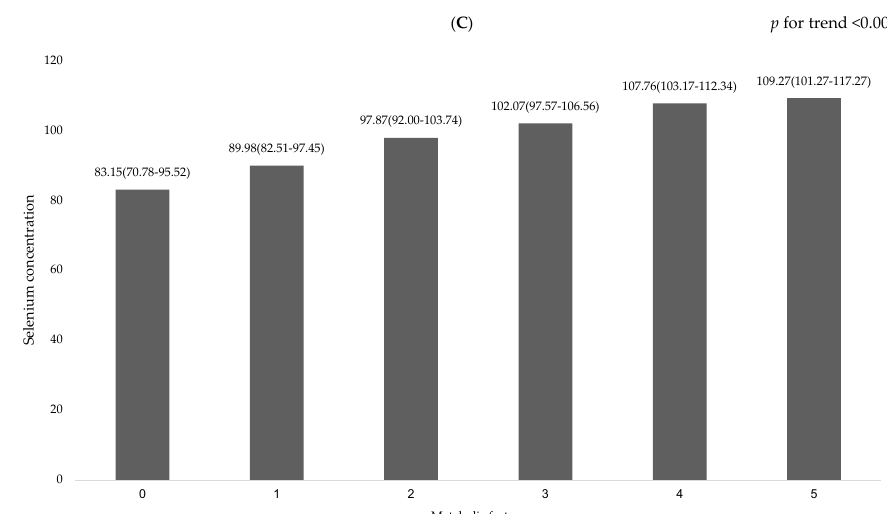
Figure 2. Comparison of serum selenium concentration in relation to number of metabolic factors. (A) All subjects; (B) Female subjects; (C) Male subjects.